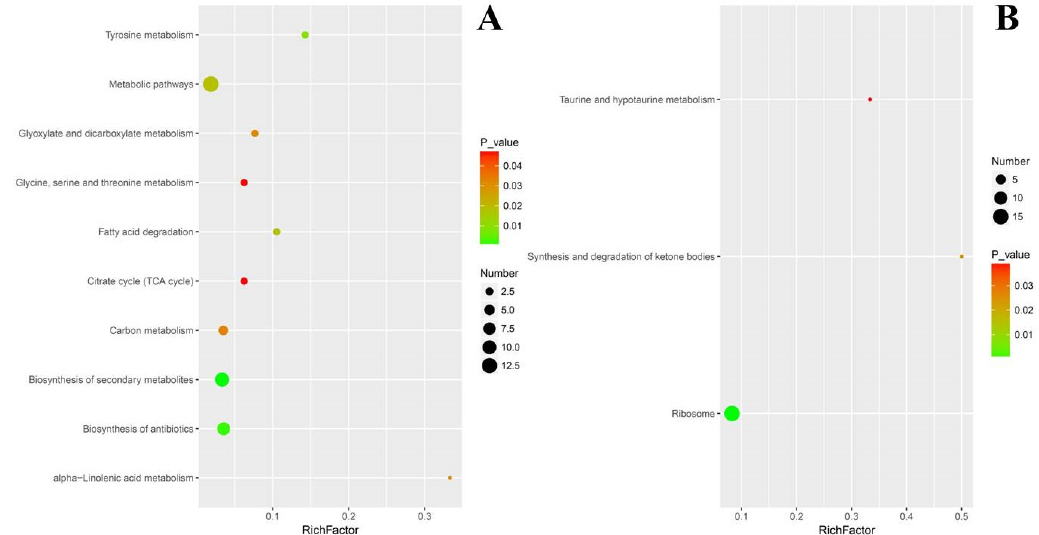
Figure 9. Rich-factor scatter plot of select pathway enriched with DEPs. ( A ) Up regulated DEPs. ( B ) Down regulated DEPs. Rich factor indicating the number ratio of differentially expressed proteins to total annotated proteins in a pathway. Dot areas show the number of DEPs, and the selection was based on KEGG enrichment situation and pertinence to the metabolic blocks in the fungal response to cuminal exposure.